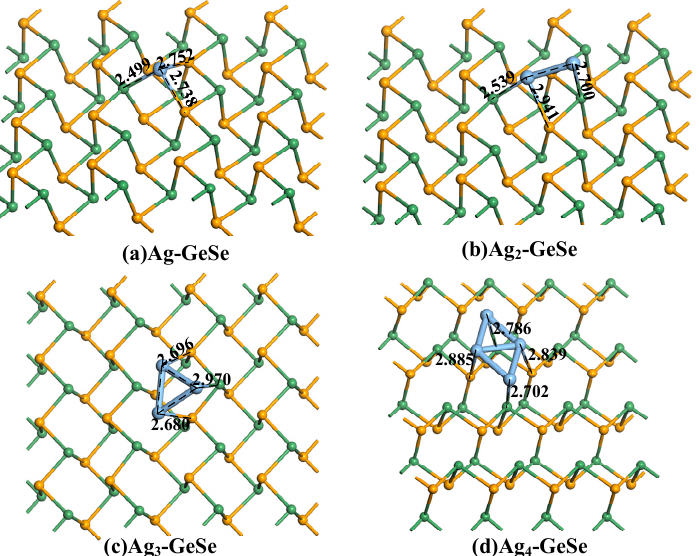
Figure 2. The stable structures of Ag n -GeSe. ( a ) Ag-GeSe, ( b ) Ag 2 -GeSe, ( c ) Ag 3 -GeSe, ( d ) Ag 4 -GeSe. The distance is in Å.